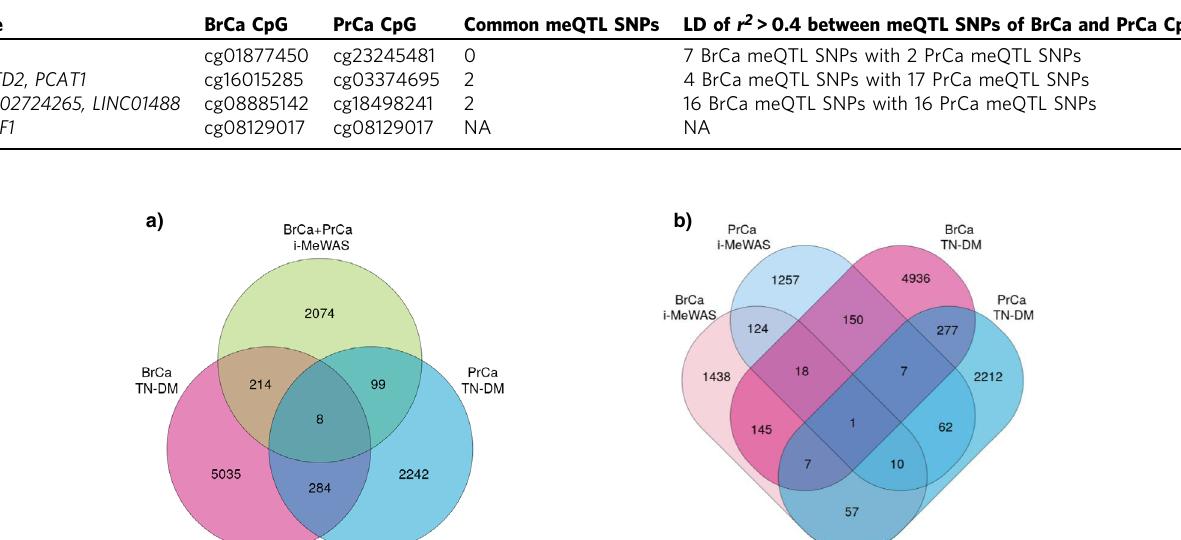
Fig. 4 Cross cancer analysis to identify the pleiotropic DM CpGs between breast cancer (BrCa) and prostate cancer (PrCa). a Venn overlap of i-MeWAS results using BrCa and PrCa meta-analysed GWAS-SS (BrCa + PrCa i-MeWAS), differential methylation results of tumour vs NAT in BrCa (BrCa TN-DM), and differential methylation results of tumour vs NAT in PrCa (PrCa TN-DM). b Venn overlap of independent i-MeWAS results using BrCa GWAS-SS (BrCa i-MeWAS) and PrCa GWAS-SS (PrCa i-MeWAS), and independent differential methylation results of tumour vs NAT in BrCa (BrCa TN-